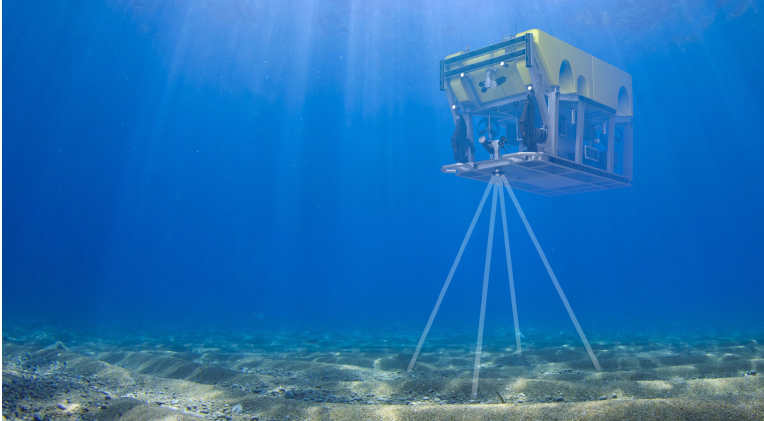
Figure 4. A schematic showing a Doppler Velocity Logs (DVL) being used to track the velocity of a UUV relative to the sea bed, reproduced from